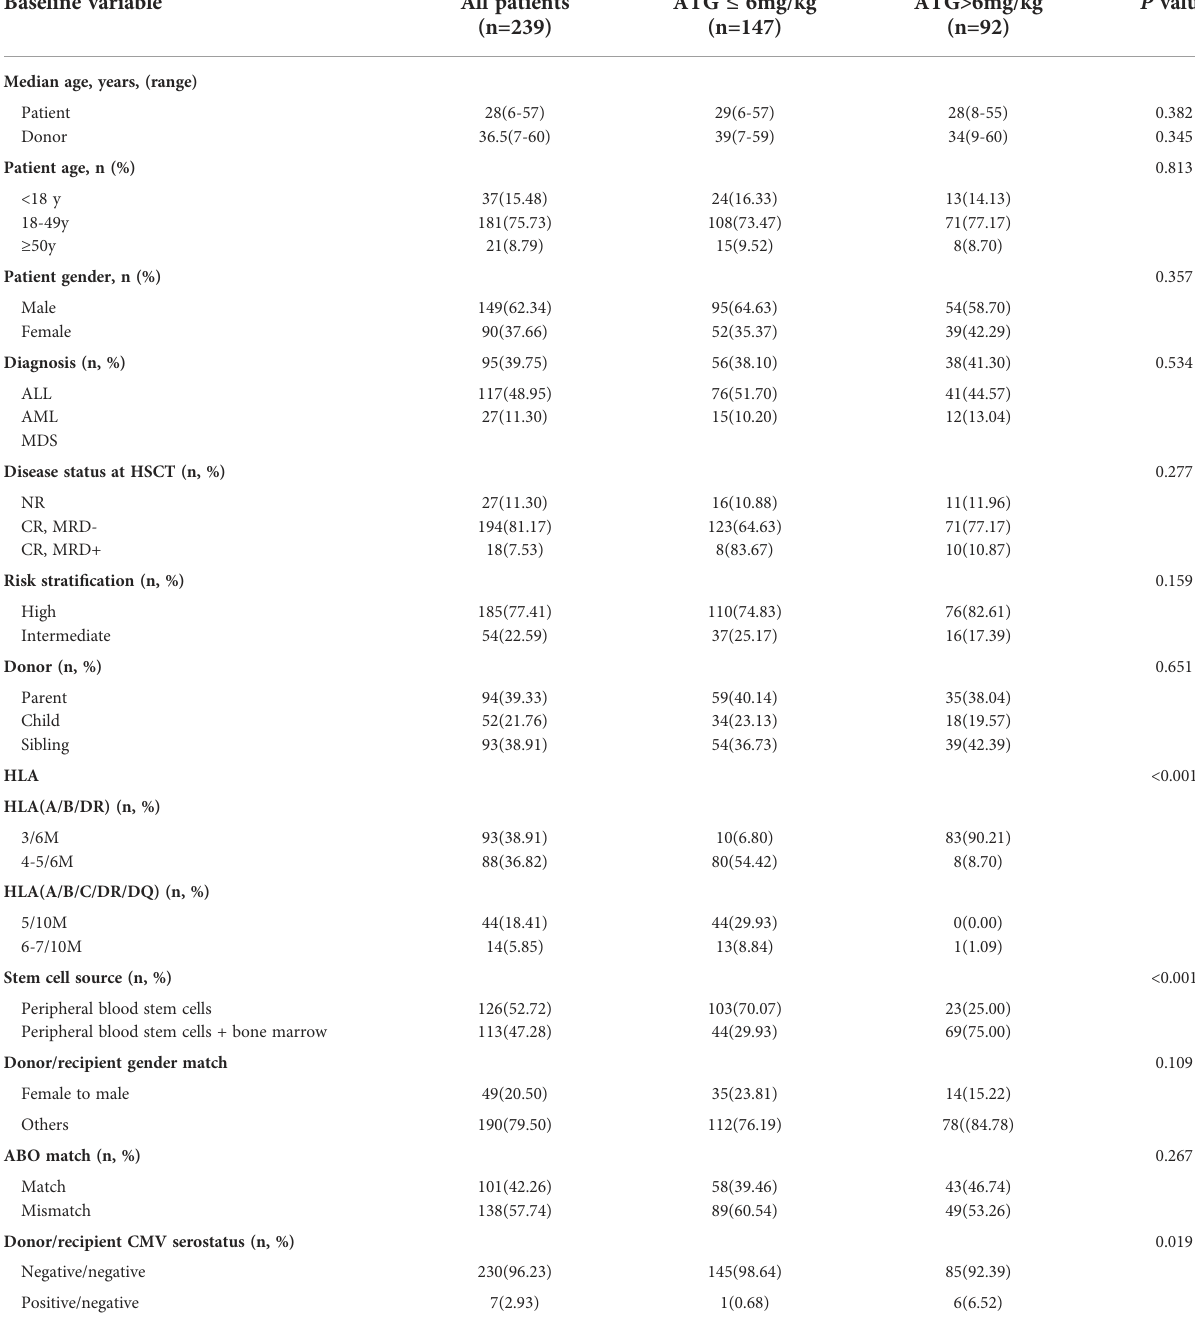
TABLE 1 Patient and donor